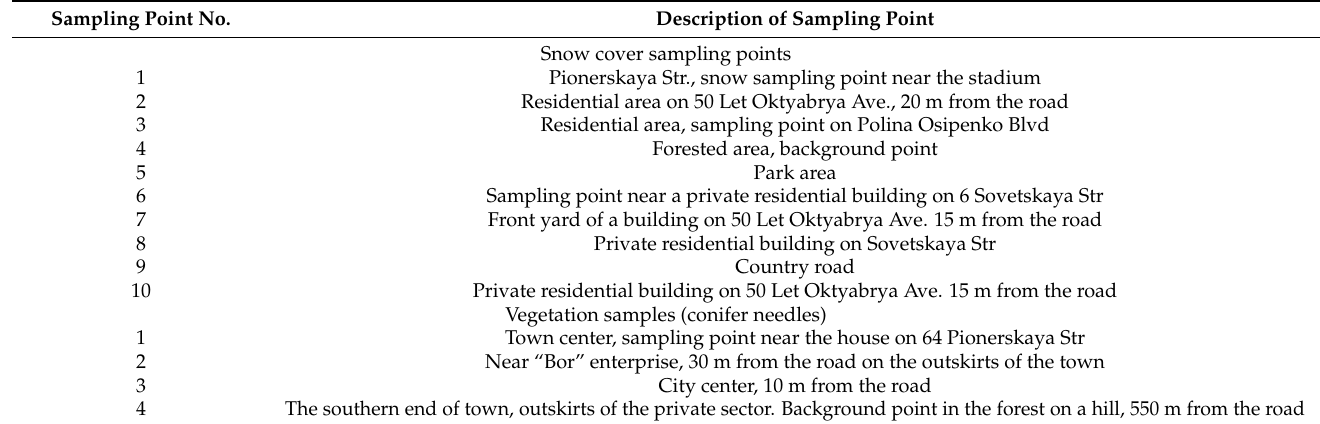
Table 1. Description of sampling points in Dalnegorsk